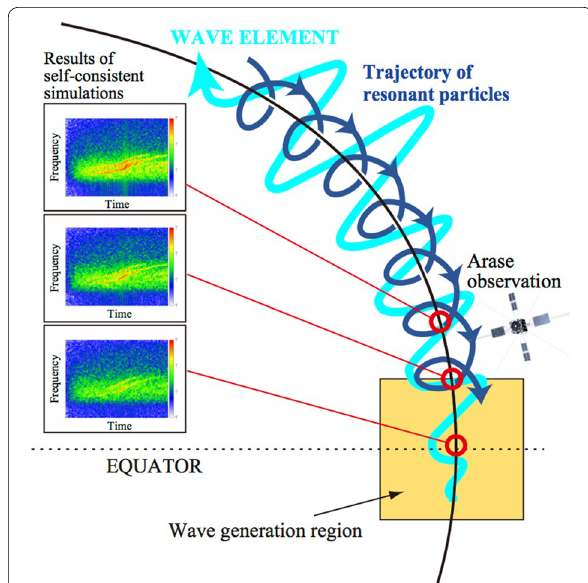
Fig. 9 Schematic diagram of roles of self‑consistent